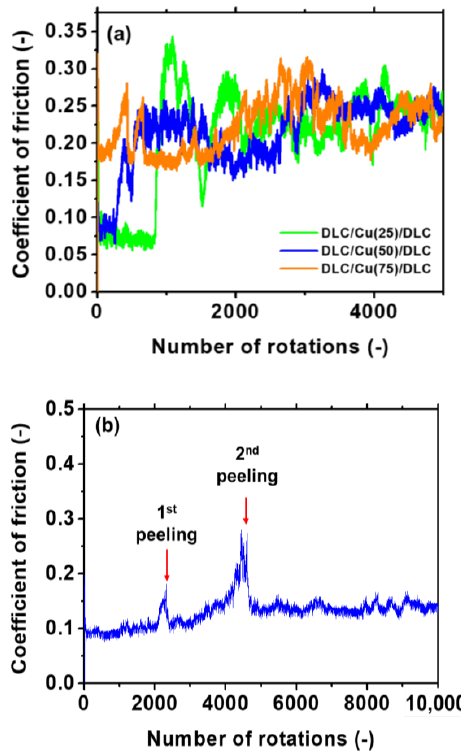
Figure 11. Results of the BoD test for the samples in ( a ) group B and ( b ) group C.